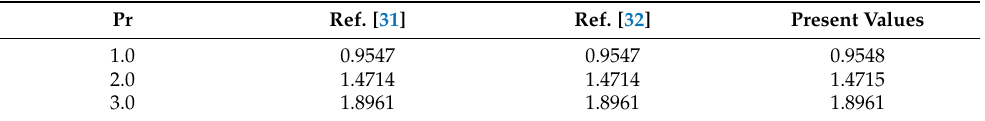
Table 1. Comparison of the current analysis with previous studies.